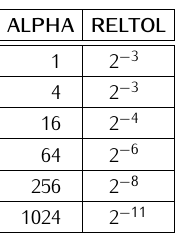
Table 16. The largest values of parameter RELTOL for which at least one of the preconditioned methods was able to successfully solve the system containing 16 · 10 6 equations when different values of ALPHA are used in connection with matrices of CLASSF